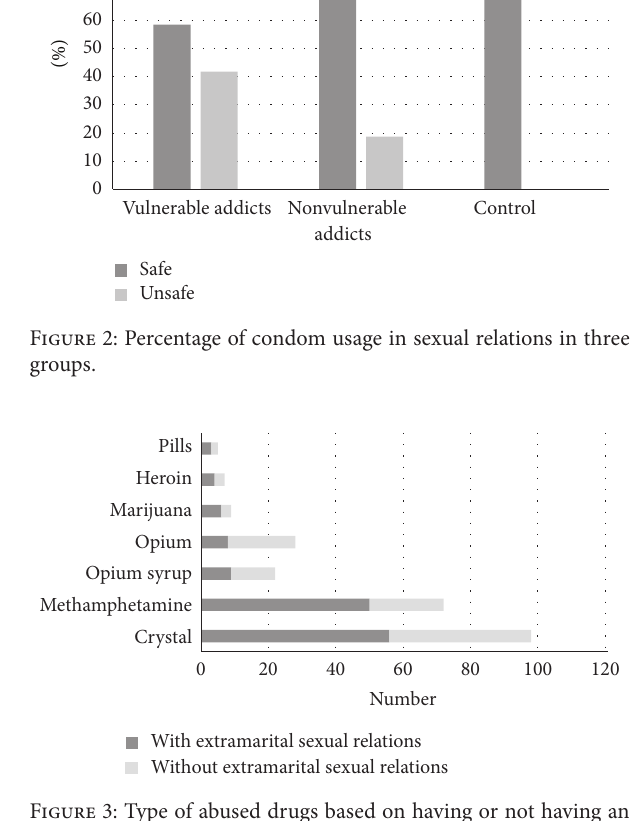
Figure 3: Type of abused drugs based on having or not having an extramarital sexual